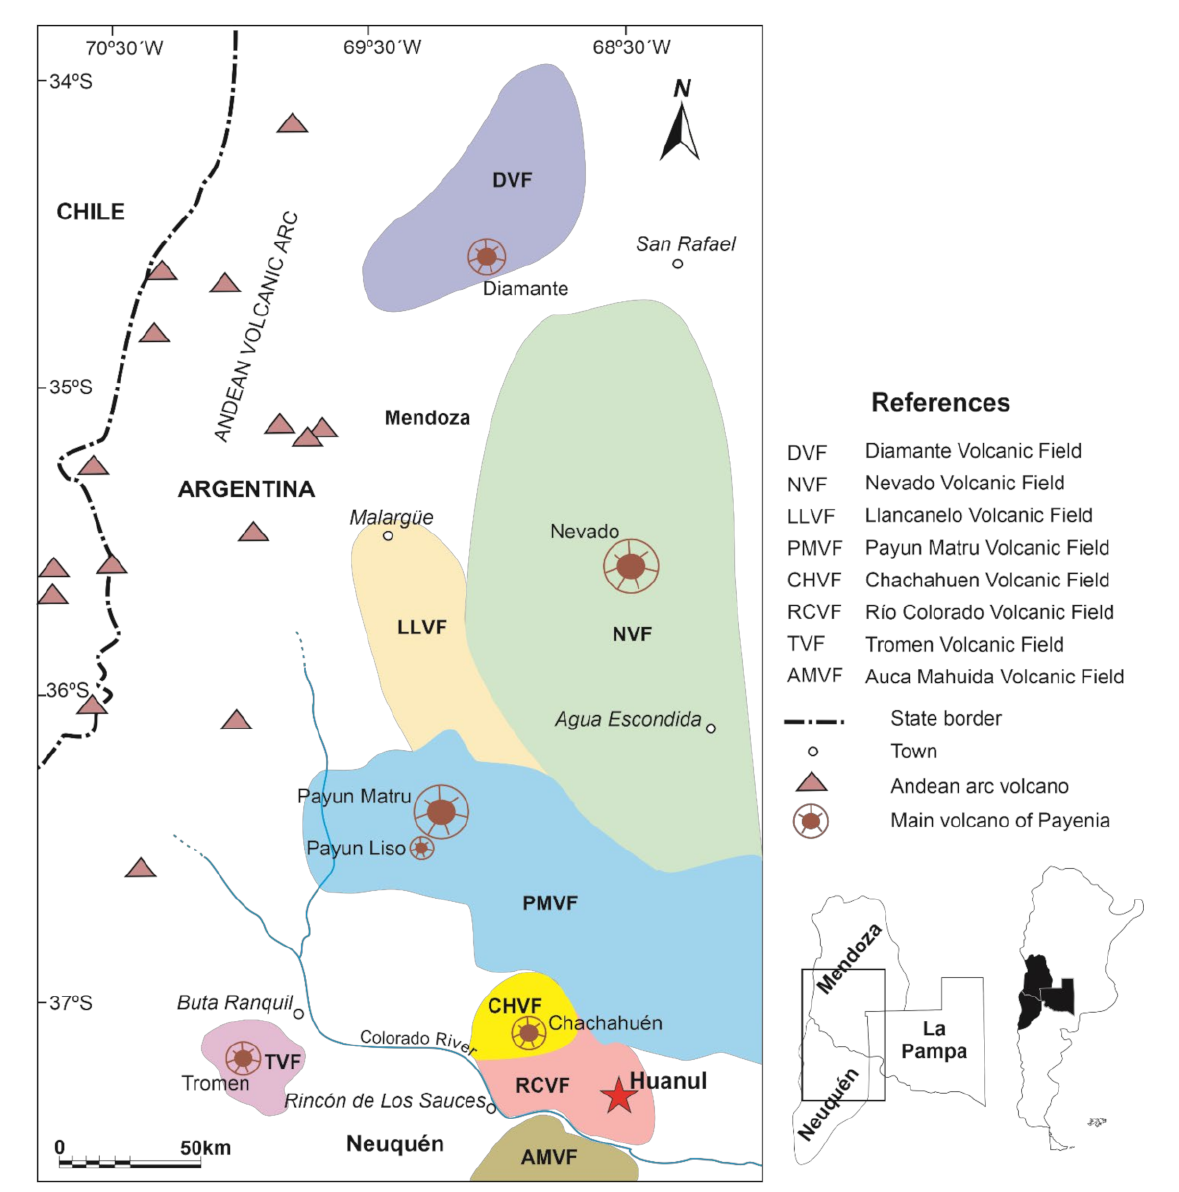
Figure 1. Geological sketch map of the Payenia Volcanic Field showing the Huanul volcano, modified from Bernardi et al.